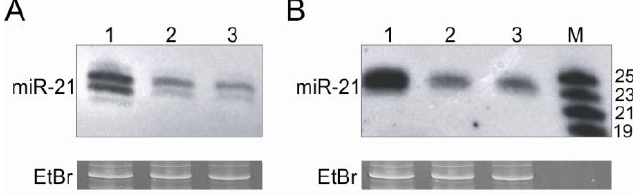
FIGURE 4. Cross-linking of RNAs onto membranes. Hybridization of probes to endogenous miR-21 following UV cross-linking (A) and EDC cross-linking (B). Numbers 1, 2, and 3 denote the RNAs extracted from different cell lines. M denotes a molecular size standard (19-, 21-, 23-, and 25-nt ORNs). Staining with ethidium bromide (EtBr) provides a loading